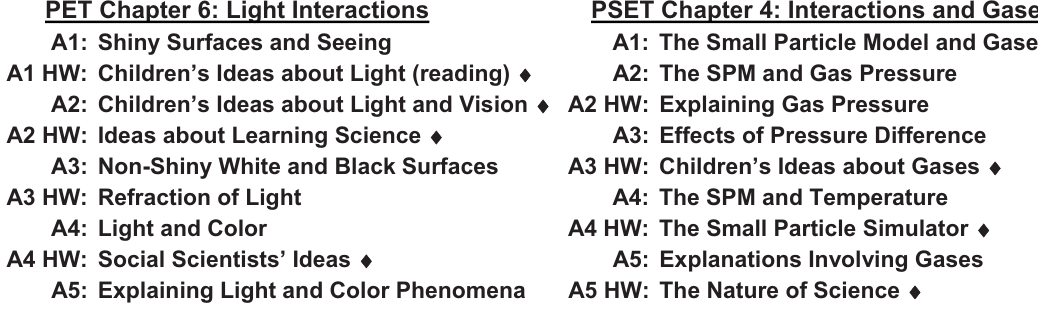
FIG. 1. Table of contents of Chap. 6 PET and Chap.